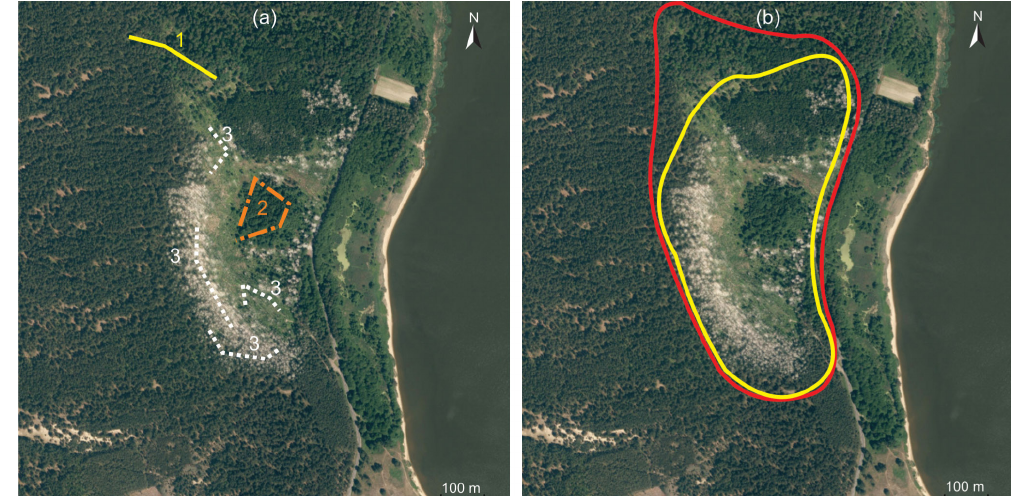
Figure 1. Trapping design in the great cormorant colony in Juodkrant˙e (a) and colony expansion in 2015 (b) . (a) Position of the trap lines in 2015: 1 – expansion, 2 – ecotone, 3 – the colony. (b) Yellow line – colony area in 2014, red line – colony expansion in 2015.